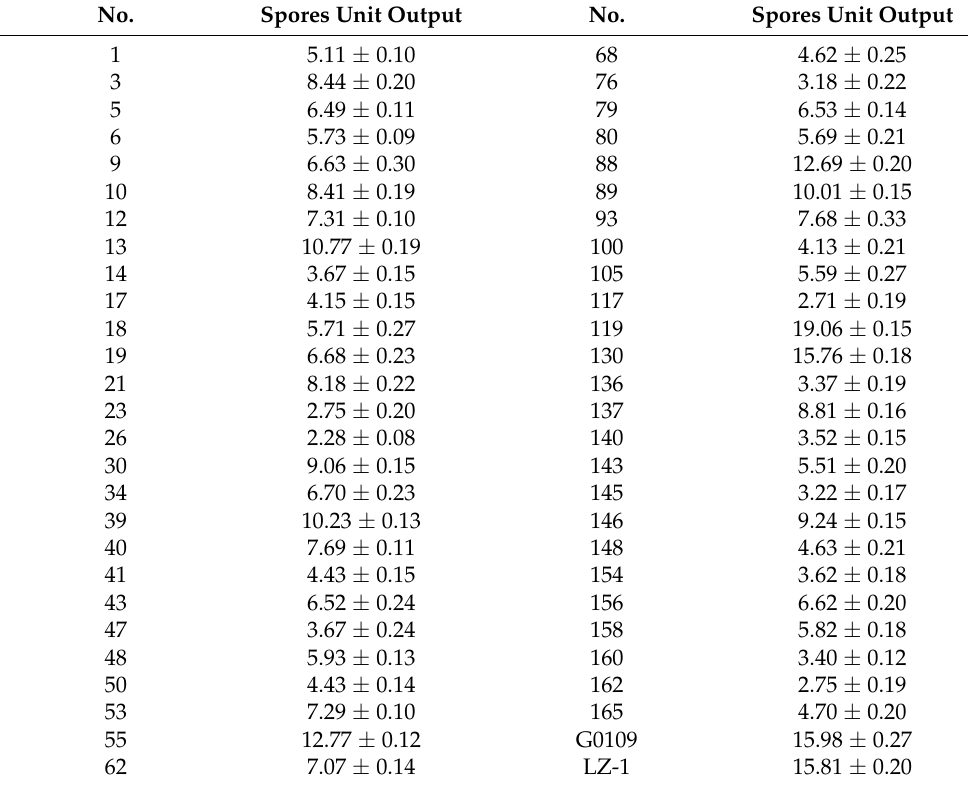
Table 4. Spore unit output (gram per spawn) of some mutagenic strains.